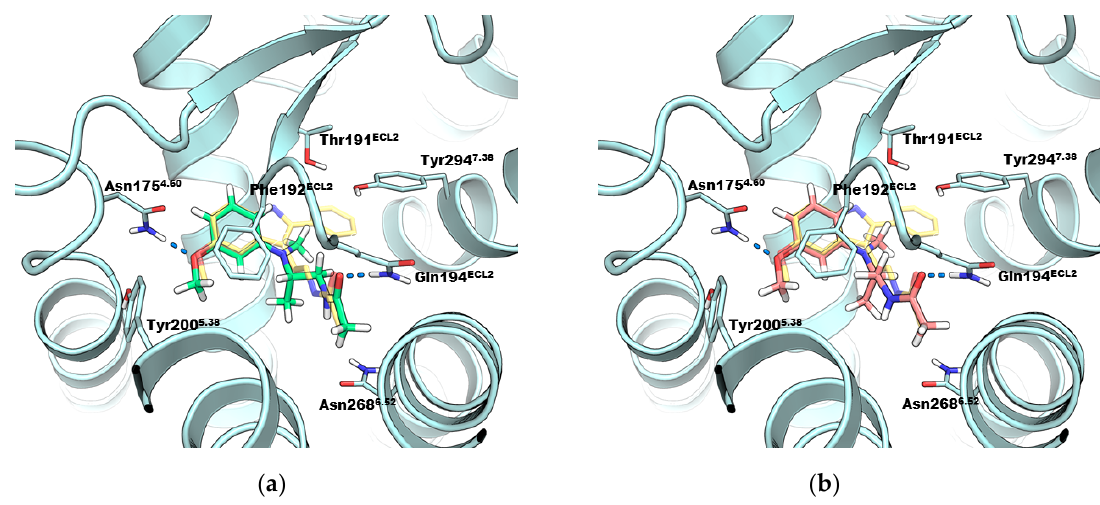
Figure 2. Proposed binding mode for compounds ( S )- 10 ( a ), green sticks and ( R )- 10 ( b ), orange sticks into the MT 2 receptor crystal structure (PDB: 6ME6), observed from the extracellular side of the receptor. Hydrogen bonds are shown as blue dashed lines. Co-crystalized 2-phenylmelatonin is shown with shaded yellow carbons. Ballesteros-Weinstein residue numbering [22] is adopted in superscripts.